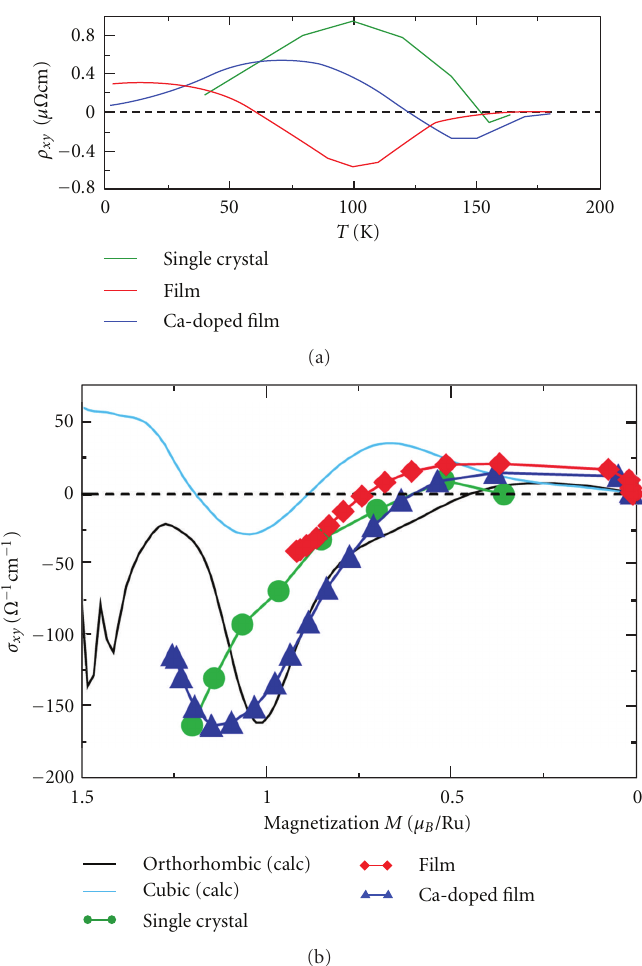
Figure 2: (a) A plot of transverse resistivity, ρ xy , against T for SrRuO 3 . The strong temperature-dependence cannot be explained by impurity- based extrinsic AHE mechanisms. (b) A comparison with experimental results of first-principle calculations of the Berry curvature and σ xy as a function of the magnetization, M . The calculations for the orthorhombic phase closely match those of experiment by accounting for the exchange splitting of the bands. All figures are taken from [8].